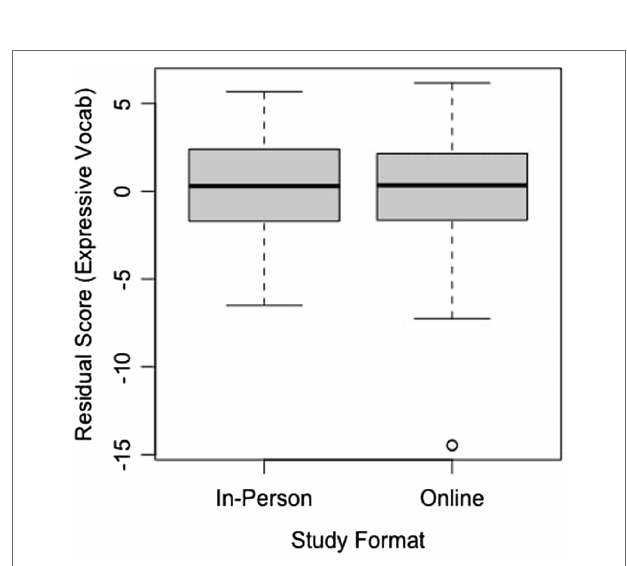
FIGURE 9 | Residual scores for both formats of the expressive vocabulary section of the spatial language